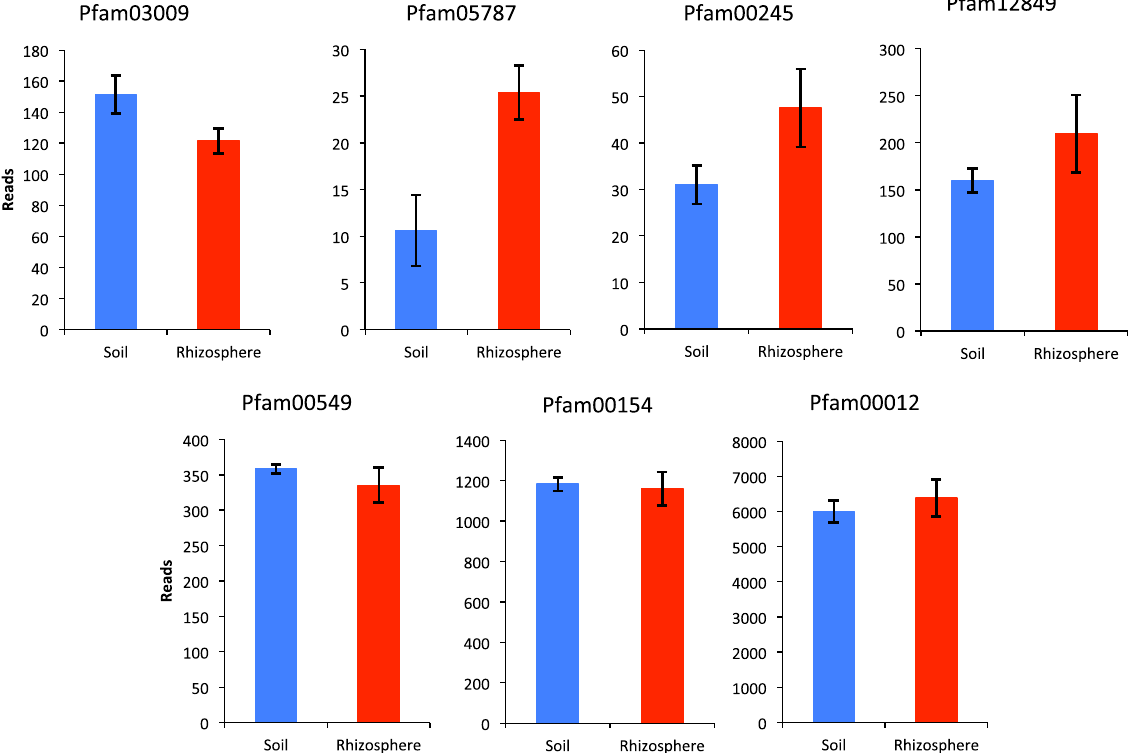
Figure 6. The number of transcripts encoding Pfam domains associated with various phosphate (Pi)- scavenging and housekeeping functions detected in the metatranscriptomes (MT) sample at the Kellogg Biological Station, Michigan, USA. Results shown are the mean of triplicate cultures. Error bars denote standard deviation. Pfam03009, glycerolphosphodiester phosphodieasterase; Pfam05787, alkaline phosphatase –